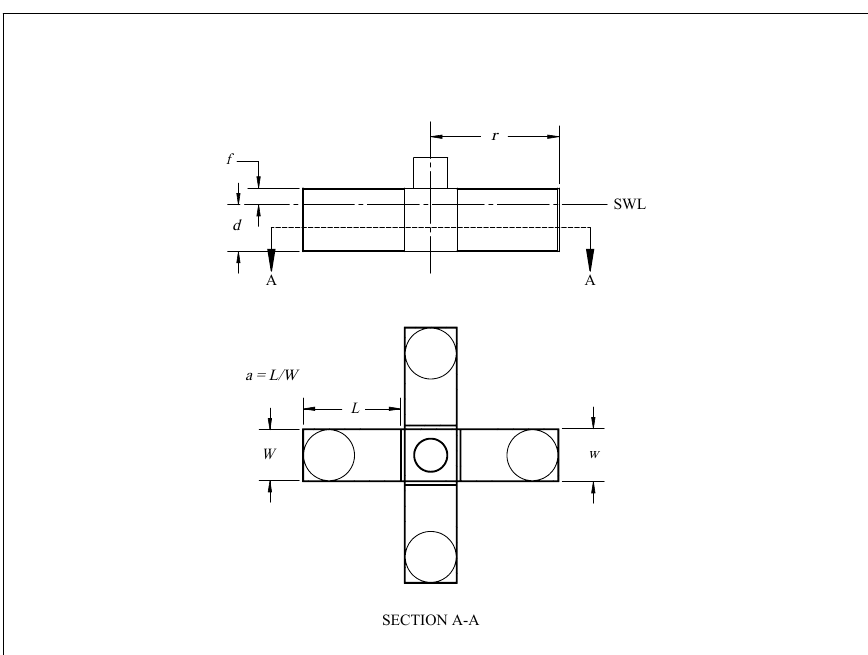
Figure 6. A diagram showing the definition of the input variables.